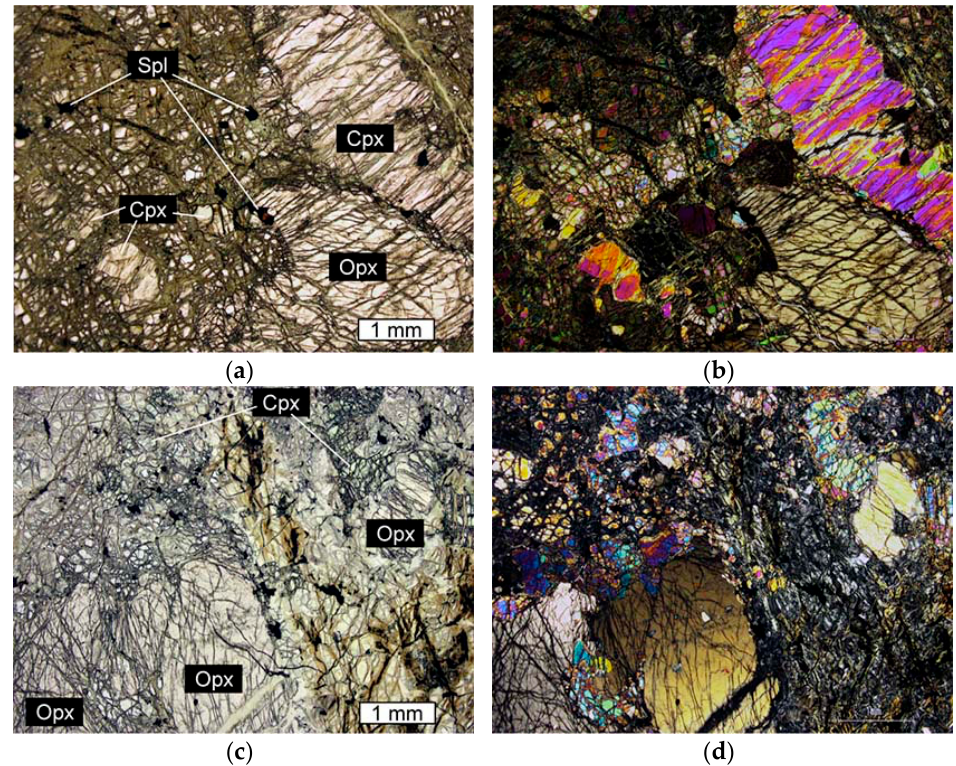
Figure 4. Photomicrograph of the studied lherzolite samples. (M31) ( a ) Plane-polarized light and ( b ) cross-polarized light images of M31. Coarse-grained clinopyroxene porphyroclast is observed. ( c ) Plane-polarized light and ( d ) cross polarized light images of M21. Cpx = clinopyroxene, Opx = orthopyroxene, Spl = spinel.